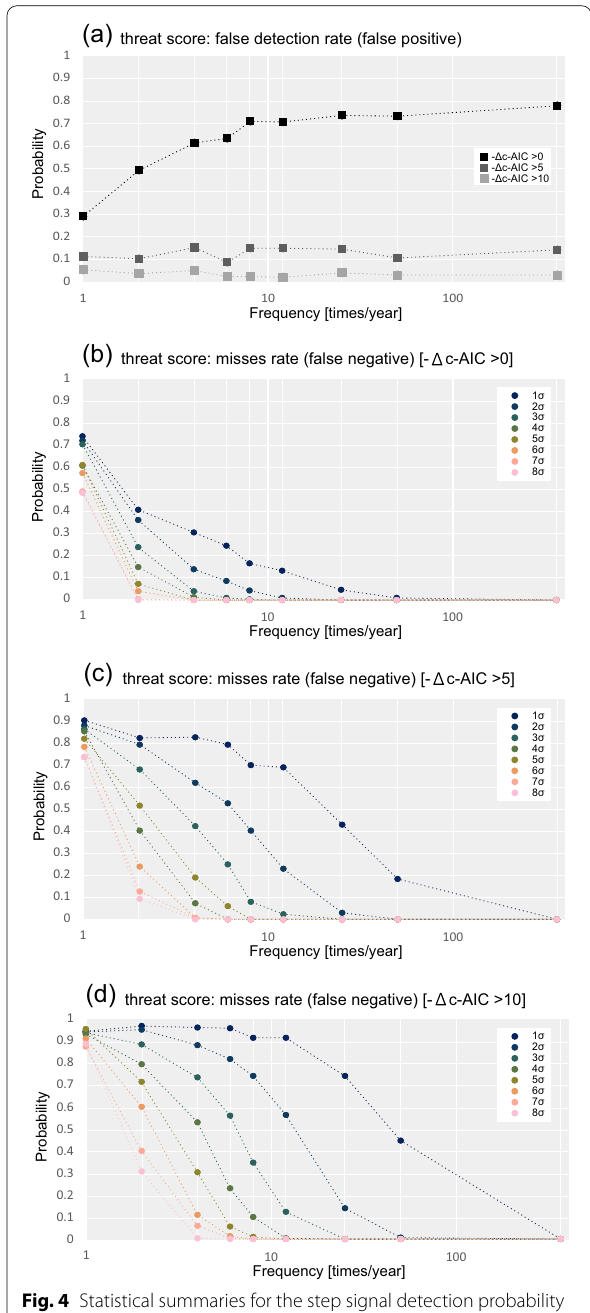
Fig. 4 Statistical summaries for the step signal detection probability in the trend and event detection. a False positive at each observation frequency, i.e., probability of the cases where an event is false detected in the no‑event synthetic data. b – d False negative, i.e., probability of the cases where no or negative event is detected in the finite‑event synthetic data; for the cases where the thresholds of –Δc‑AIC are 0, 5 and 10,